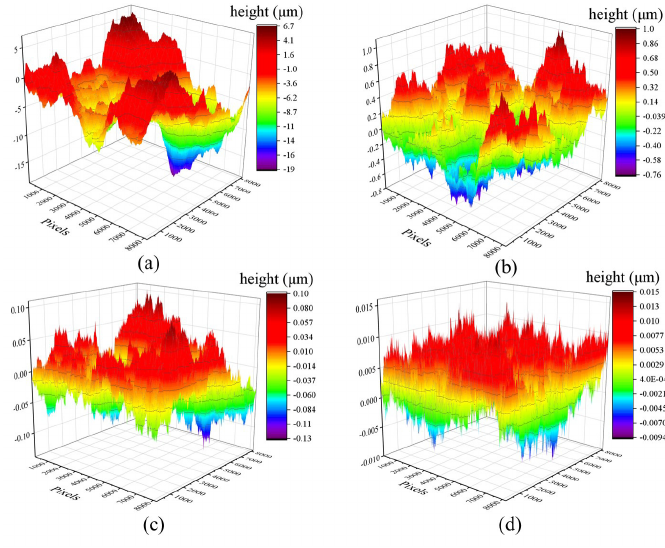
Figure 1. Artificial fractal surfaces: ( a ) D i = 2.2; ( b ) D i = 2.4; ( c ) D i = 2.6; ( d ) D i =